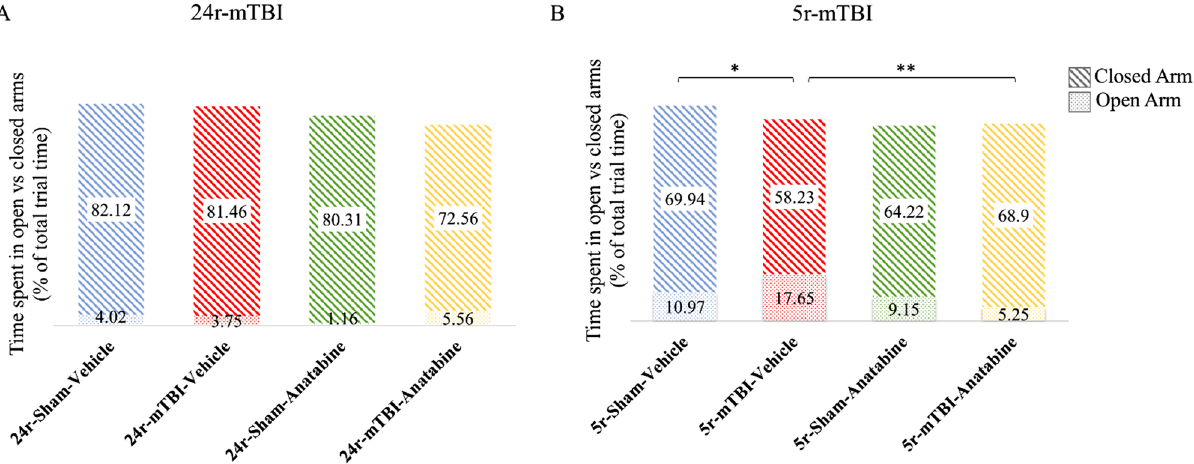
Figure 5. Evaluation of disinhibition (time spent in open vs closed arms) in the 24r-mTBI and 5r-mTBI mice using the EPM. ( A ) There was no difference in time spent in open vs closed arms between the 24r-mTBI-vehicle (3.75 vs 81.46) and 24r-sham-vehicle (4.02 vs 82.12) and between the 24r-mTBI-vehicle (3.75 vs 81.46) and 24r-mTBI-anatabine (5.56 vs 72.56). ( B ) There was an increase in time spent in the open arms in 5r-mTBI- vehicle vs 5r-mTBI-sham mice (17.65 vs 10.97, p < 0.05). In the 5r-mTBI-anatabine mice, time spent in the open arms decreased compared to 5r-mTBI-vehicle (5.25 vs 17.65, p < 0.01). Statistical significance was analyzed using one-way